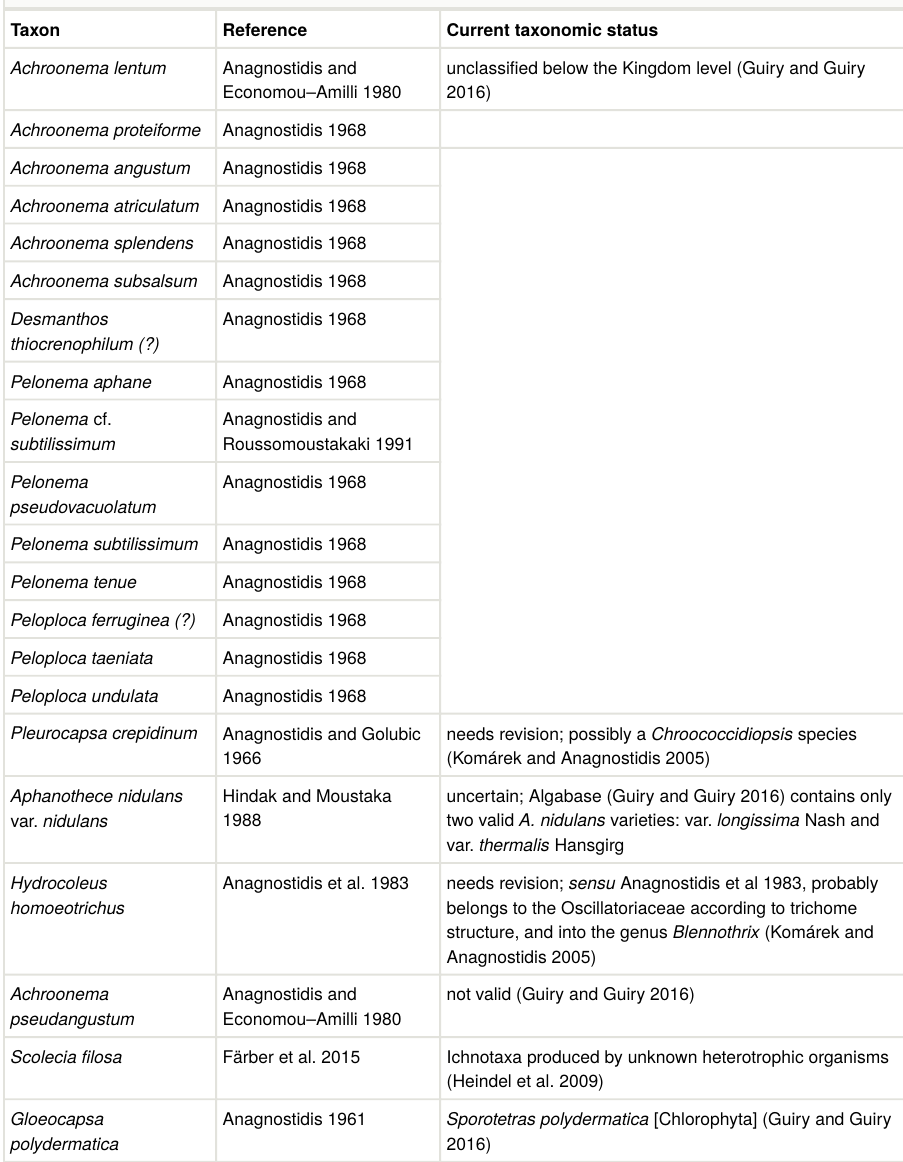
Table 2. List of cyanobacterial taxa known to occur in Greece with uncertain or not valid taxonomic status. For each taxon the publication mentioning its occurrence in Greece and the current taxonomic status is